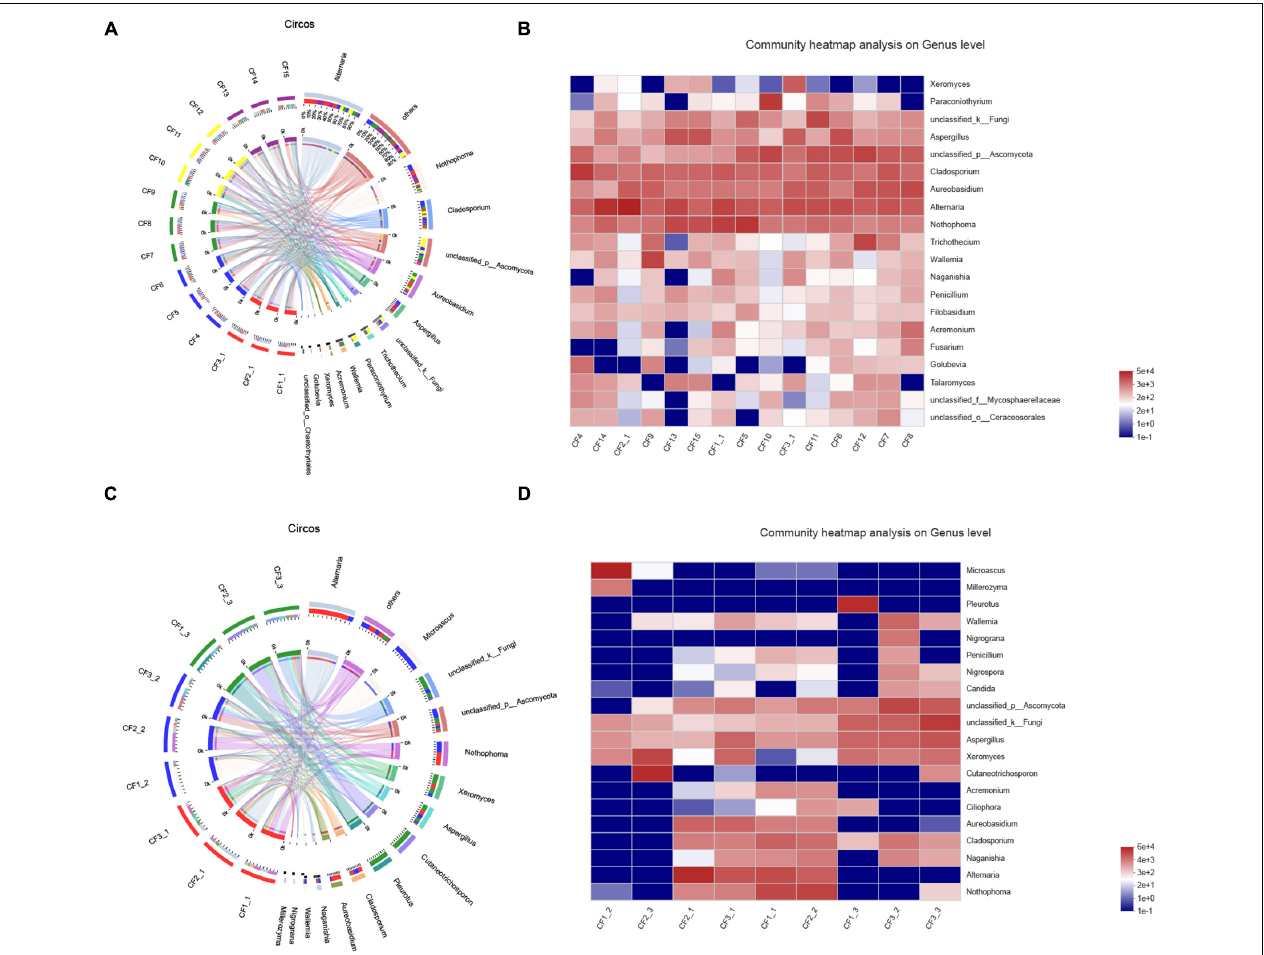
FIGURE 7 | Distribution of fungal community at the genus level in (A) samples from different collection areas visualized by Circos, (B) a heatmap of the top 20 genera in samples from different collection areas, (C) in various processed CF samples, (D) a heatmap of the top 20 genera in samples based on processing methods.